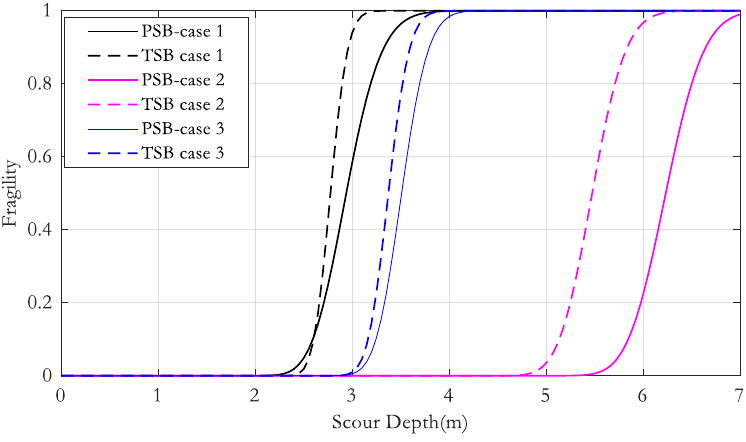
Figure 22. Comparison of top displacement of SB with different environmental conditions.